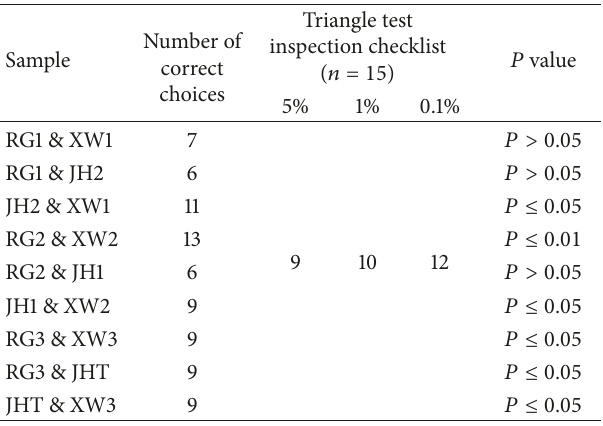
Table 2: Result of triangle test to distinguish different producing areas of dry-cured